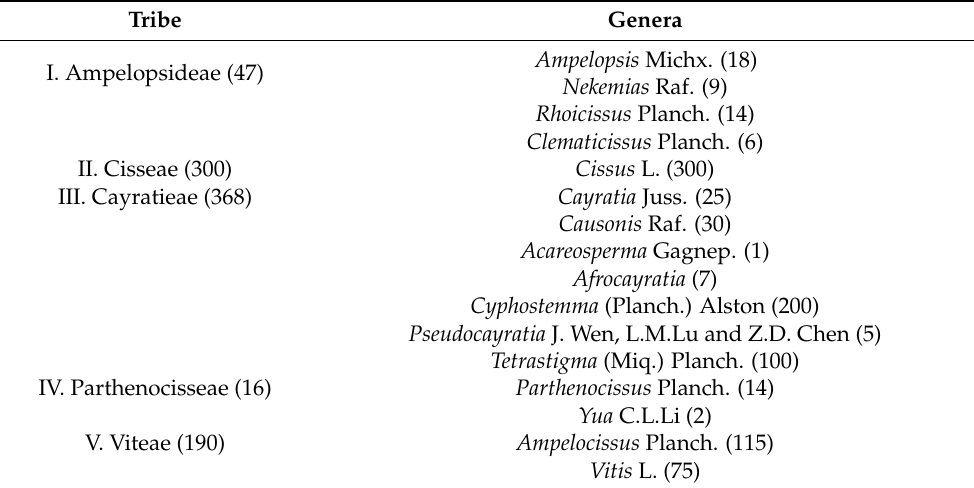
Table 1. A summary of the taxonomy of the Vitaceae. The approximate number of species in each tribe and genus is given between parentheses. Data adapted from